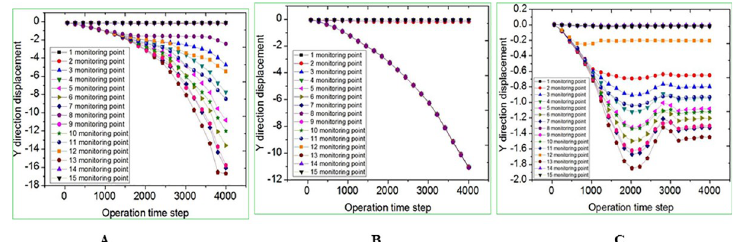
Fig 17. Displacement curve of monitoring point No.1-15 in the direction of Y-axis. (A) Inverted funnel. (B) Columnar. (C) Funnel.